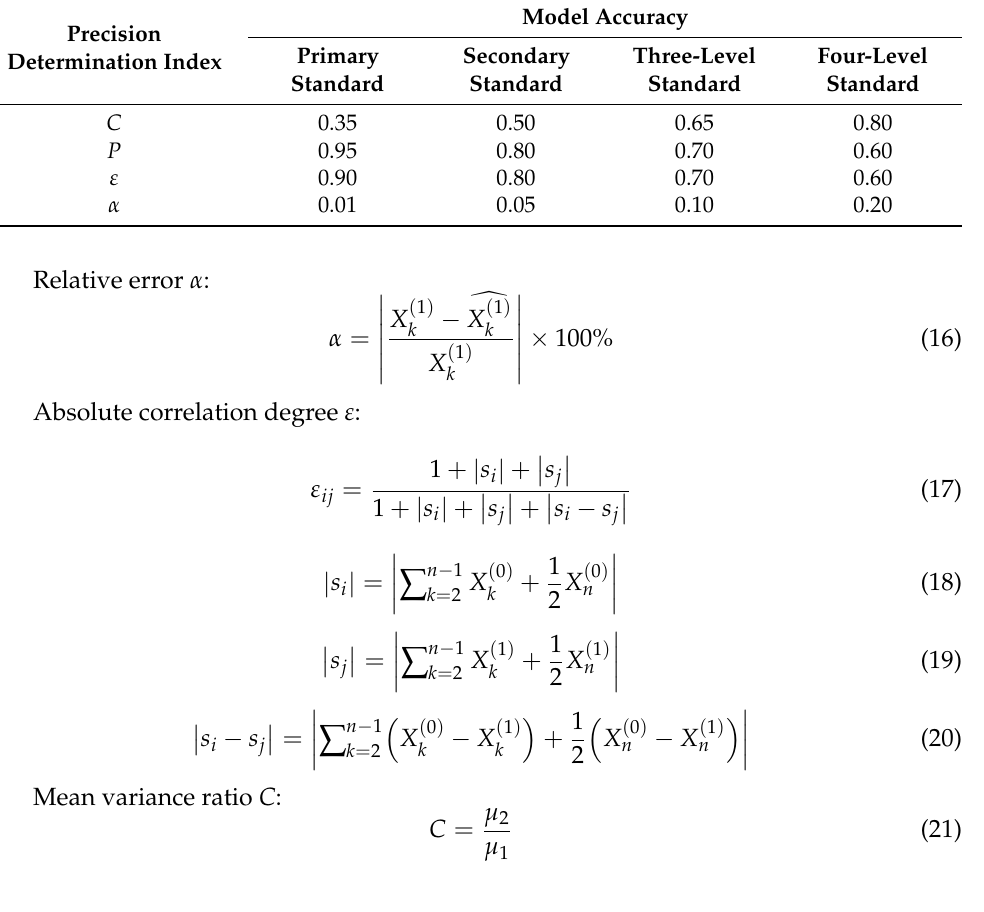
Table 8. Model established index critical